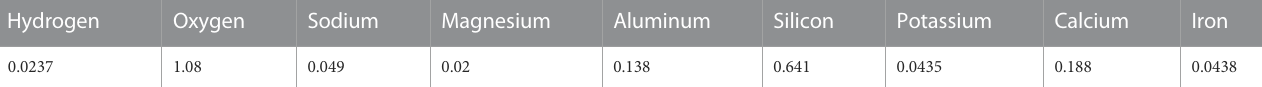
TABLE 1 Chemical composition of the shielding concrete used for the shielding experiment (Ogawa et al., 2011). The unit is g/cm 3 .